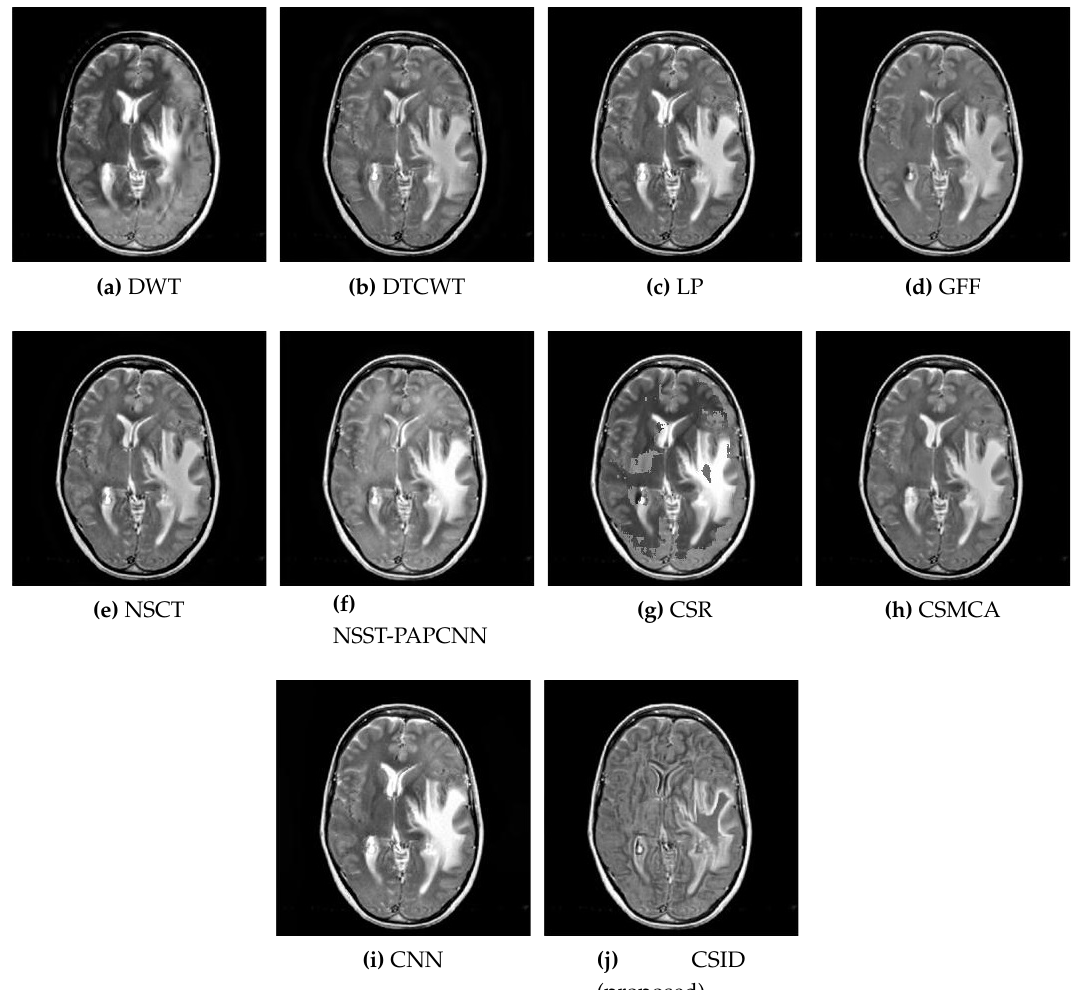
Figure 6. Comparative analysis, based upon visual observation, of the resultant fused images generated by the given set of algorithms using Data-2